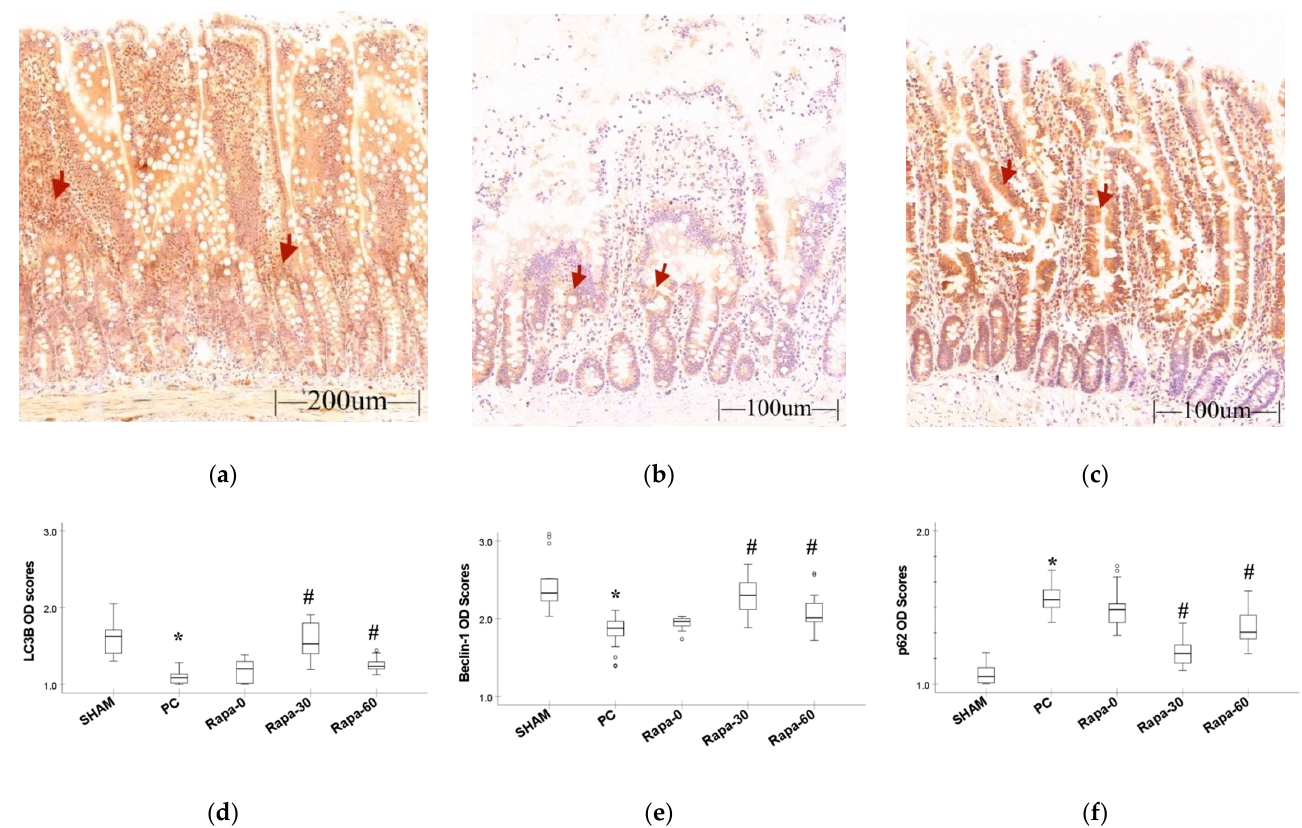
Figure 3. Immunohistochemistry result. ( a – c ) represent staining for LC3B protein for sham, PC, and Rapa-30 groups, respectively. This method stains the cytoplasm and certain elements in the lamina propria brown (red arrows are examples of immunoreactive areas). ( d – f ) are graphical representation for changes in the IHC optical density scores for LC3B, Beclin-1, and p62 proteins, respectively. Data are median and interquartile range. n = 6. * p ≤ 0.001 for PC vs. sham. # p ≤ 0.05 versus PC. (Representative pictures for Beclin-1 and p62 staining can be found in Supplementary Material Figure